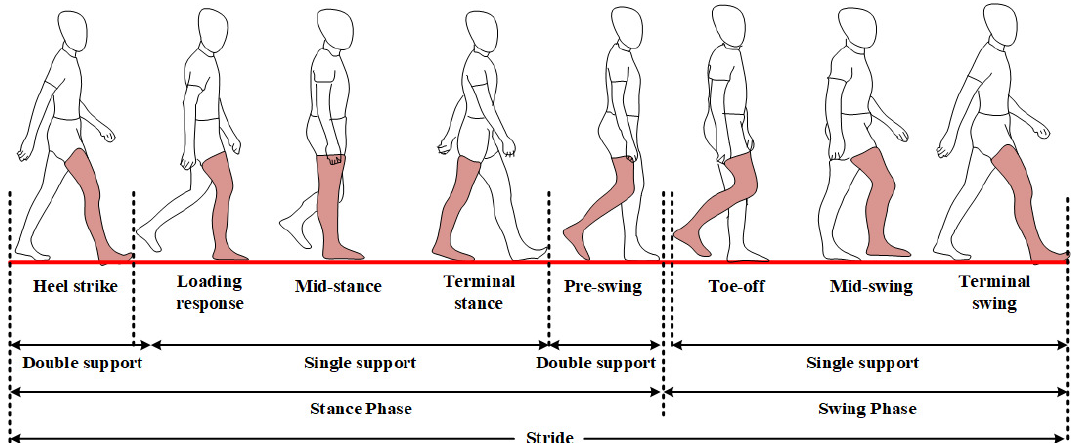
Figure 3. A stride consisting of multiple actions of legs and